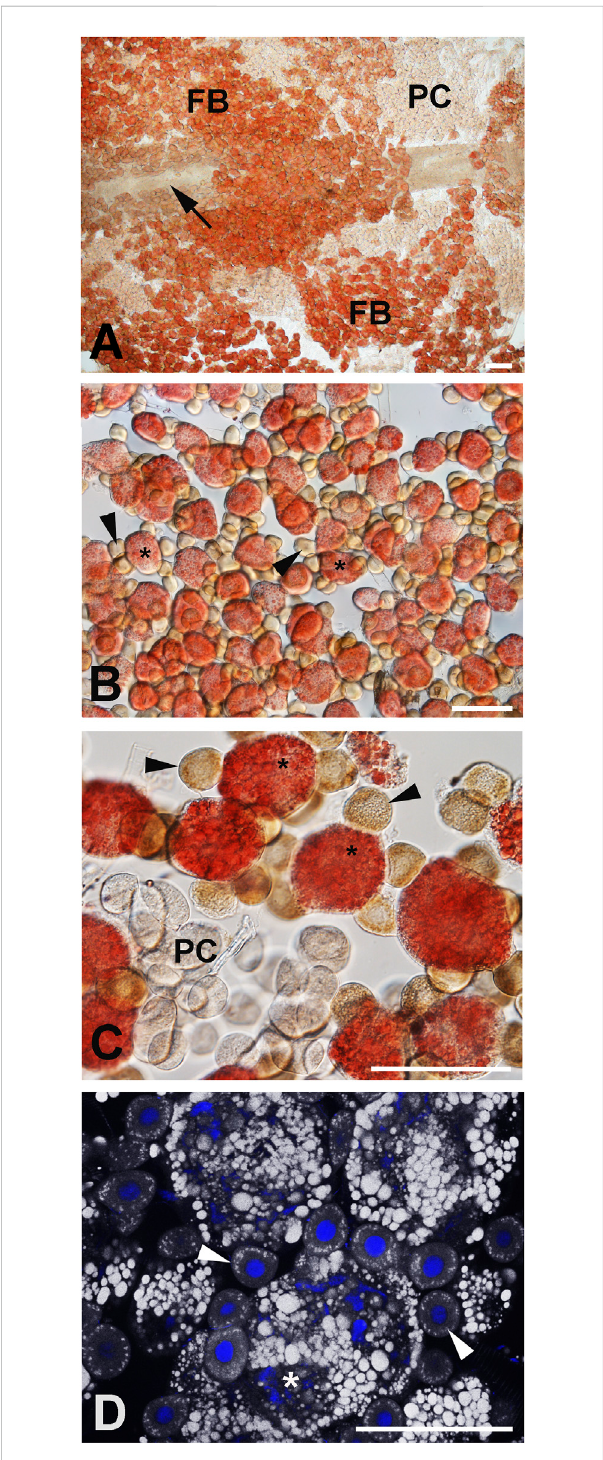
FIGURE 4 Topography of the abdominal part of the parietal fat body and pericardialcellsina3-day-oldvirginqueen.Lipiddropletswerevisualized by Oil Red O staining and imaged by light (A – C) and fl uorescence microscopy (D) . The pericardial cells (PCs) form an integral strip along the tubular heart (arrow) and the dorsally laid layer of the fat body (FB).Lipiddroplets[red in (B,C) , andwhite in (D) ]inadipocytes(asterisks), oenocytes (arrowheads), and pericardial cells (PC). Nuclei are stained by DAPI (blue) in (D) . Scale bars in (A) 200 μ m, in (B – D) 100 µm.